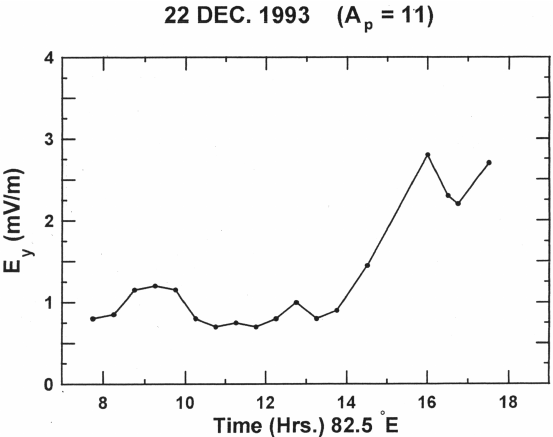
Fig. 6. Daytime variation of the estimated E y (taking into account ν ∗ e ) on 22 December 1993. The sharp increase in the electric field magnitude between 14:00 and 16:00 is to be noted in